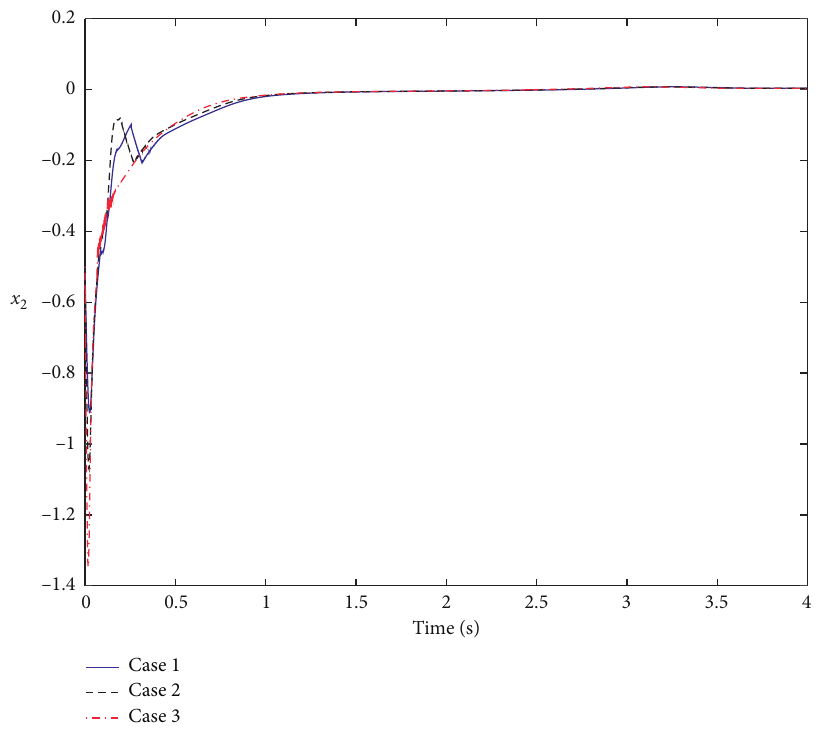
Figure 5: The trajectories of the system state x